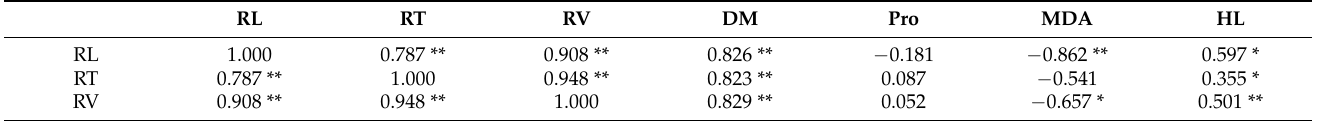
Table 1. The correlation analysis of physiological traits and hydraulic